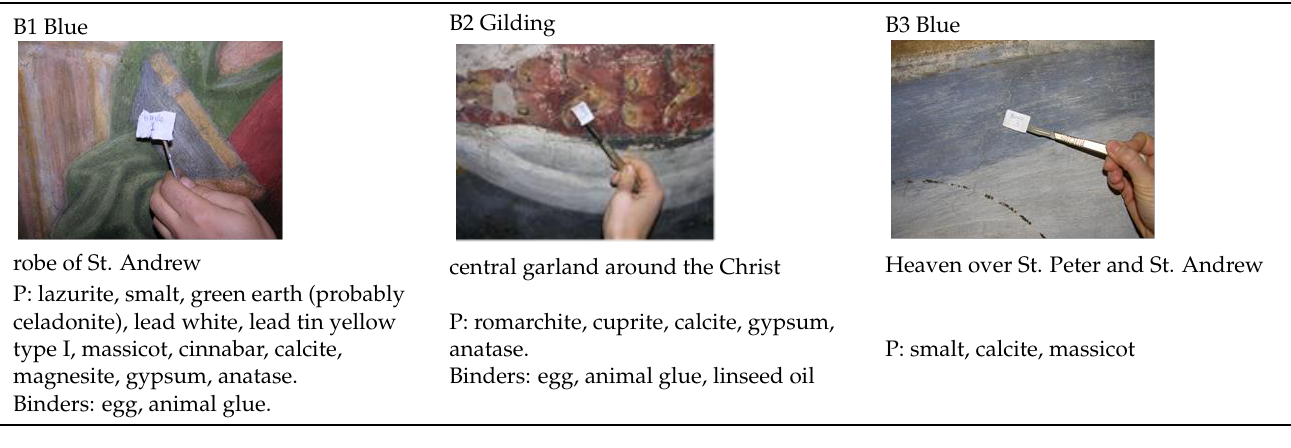
Figure 2. The sub-arch of Del Bono Chapel in the Abbey Church of S. Giovanni Evangelista in Parma: the numbers refer to the micro-sampling points (B1 to B22 samples in Table 1). Table 1. The collected samples (B1 to B22), their color and their description. Under each sample the list of pigments (P) and other substances detected by Raman spectroscopy is reported. For the samples analysed by means of GC/MS, the binders found are indicated.